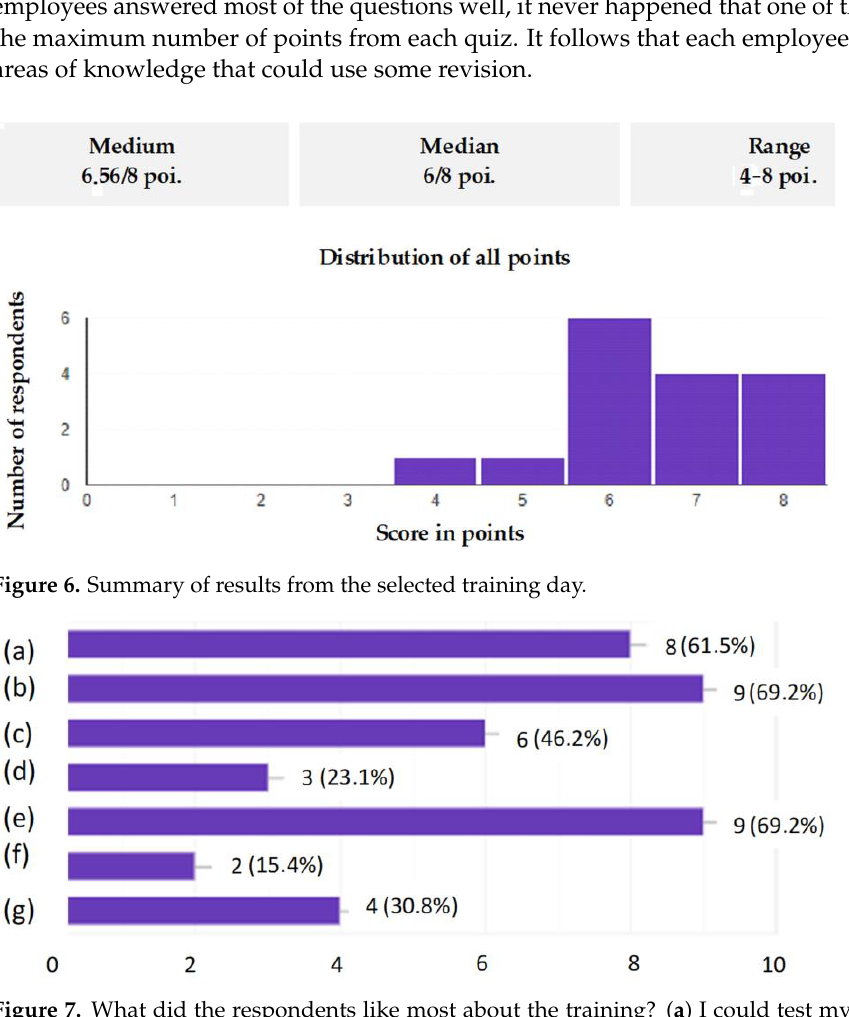
Figure 7. What did the respondents like most about the training? ( a ) I could test my knowledge; ( b )